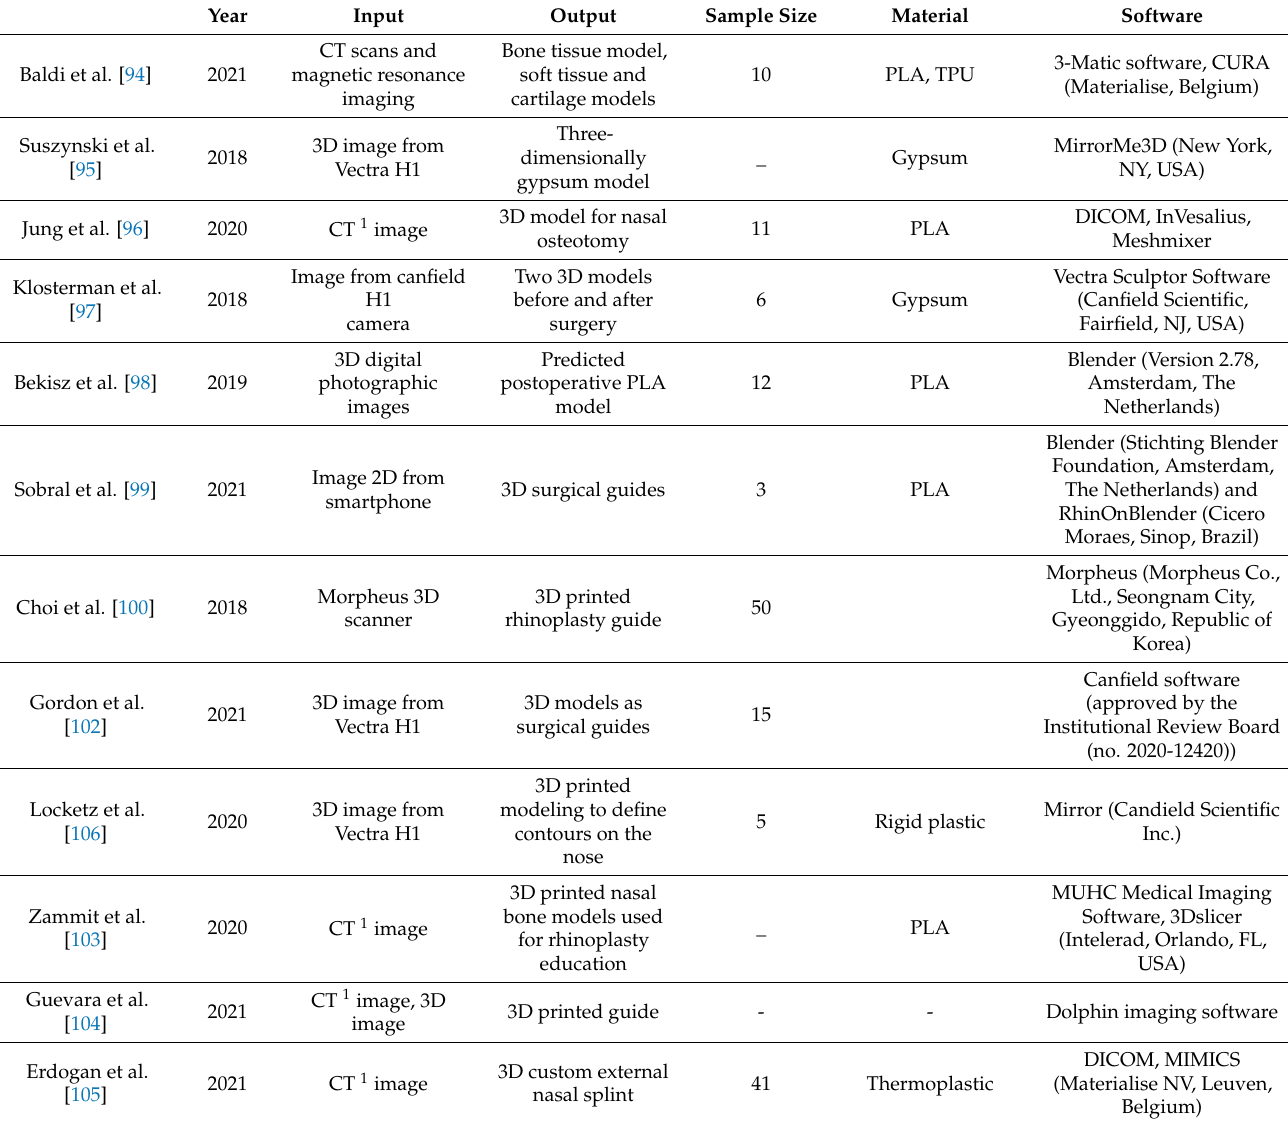
Table 4. Summary of nasal reconstruction studies using 3D